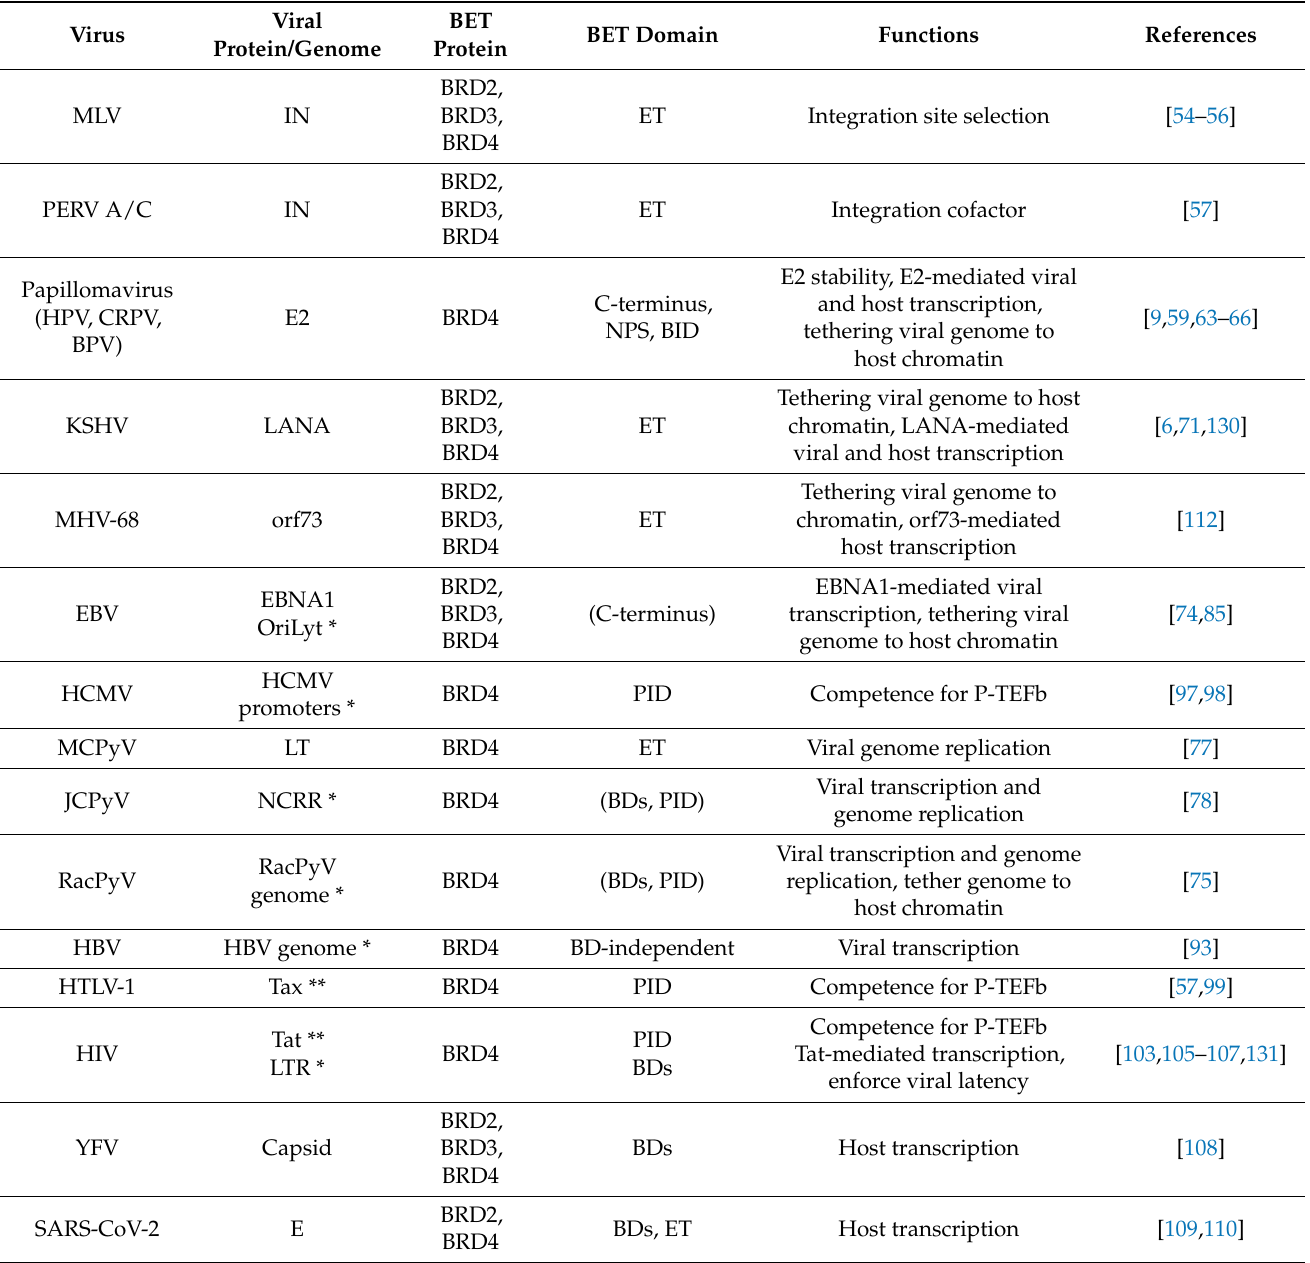
Table 1. BET protein interactions with viruses. Parentheses indicate punitive interaction domains. * indicates viral genome regions. ** indicates indirect interaction, but competition for binding to